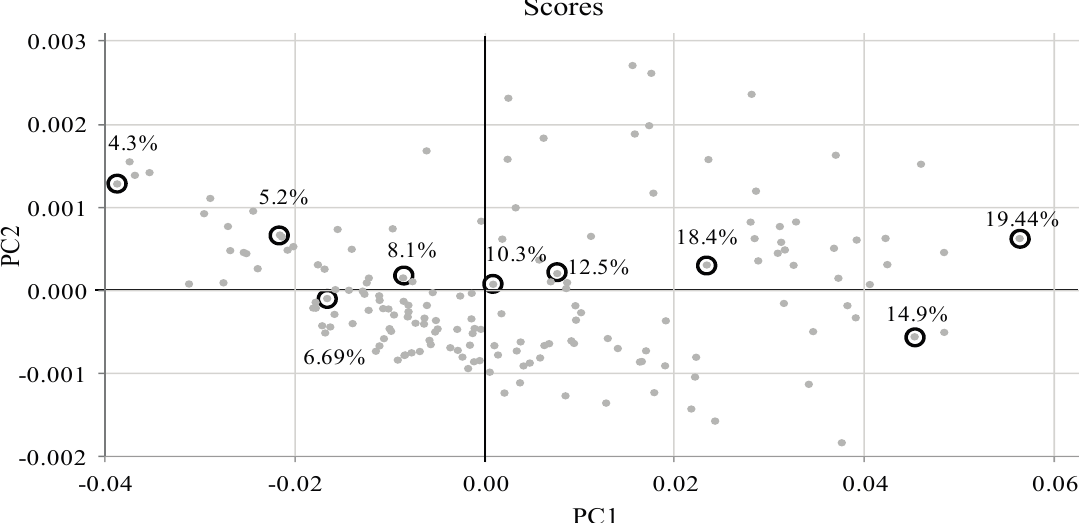
Figure 4. A score plot for the partial least squares (PLS) CP model using the 1748–1764 nm spectral